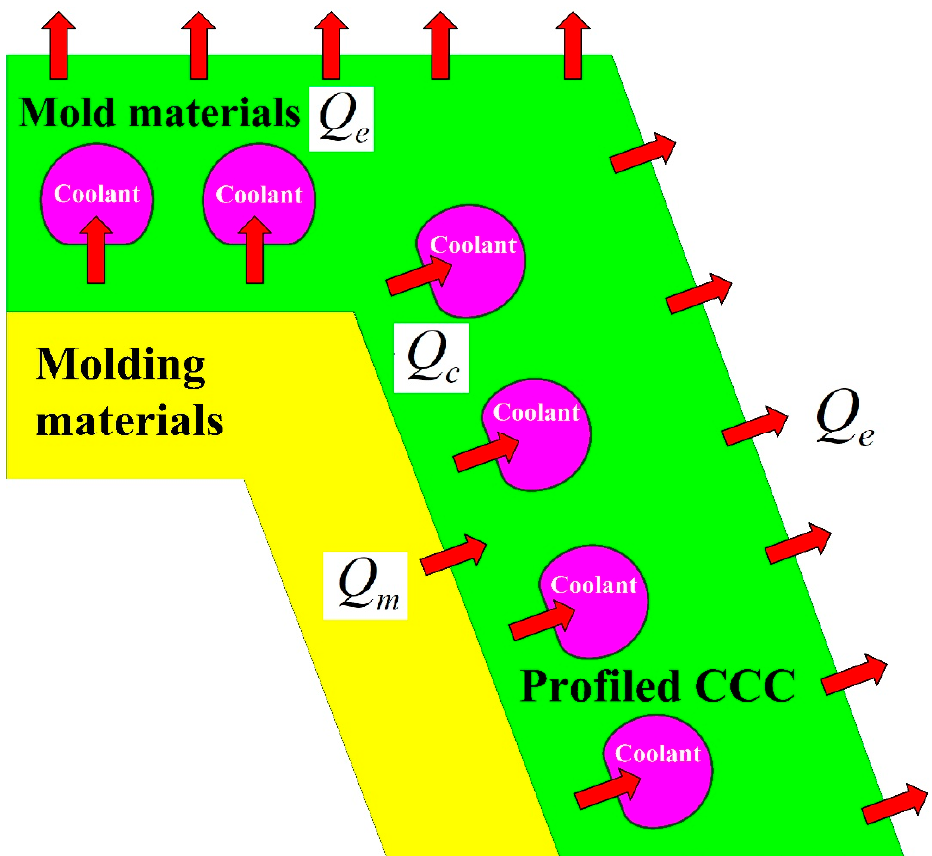
Figure 23. Schematic illustration of the heat fluxes of PCCC during the cooling stage.